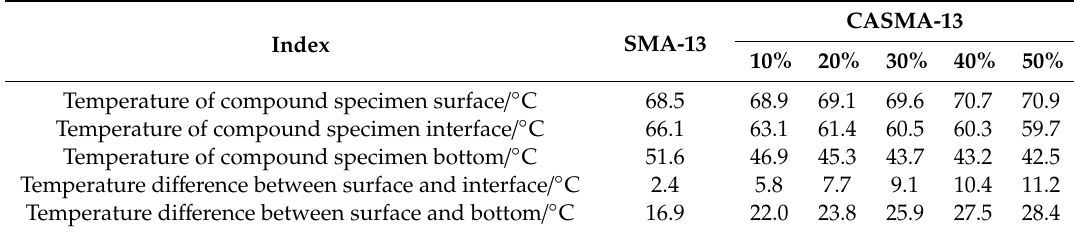
Table 9. Results of indoor thermal insulation performance